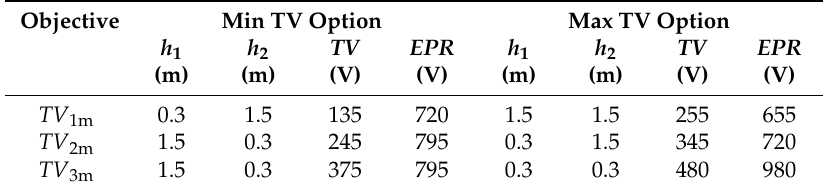
Table 5. Sensitivity analysis results for ρ 1 = 500 Ω m, ρ 2 = 100 Ω m, H = 2 m, D 2 = 5 m, D 1 = 2 m.